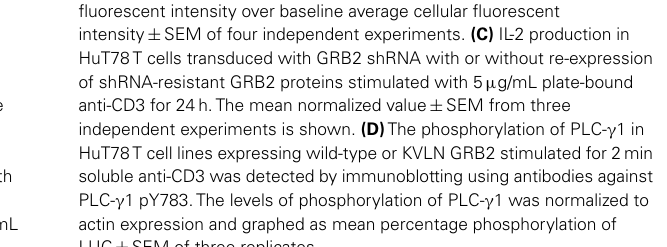
fluorescent intensity over baseline average cellular fluorescent intensity ± SEM of four independent experiments. (C) IL-2 production in HuT78T cells transduced with GRB2 shRNA with or without re-expression of shRNA-resistant GRB2 proteins stimulated with 5 µ g/mL plate-bound anti-CD3 for 24h.The mean normalized value ± SEM from three independent experiments is shown. (D) The phosphorylation of PLC- γ 1 in HuT78T cell lines expressing wild-type or KVLN GRB2 stimulated for 2min soluble anti-CD3 was detected by immunoblotting using antibodies against PLC- γ 1 pY783.The levels of phosphorylation of PLC- γ 1 was normalized to actin expression and graphed as mean percentage phosphorylation of LUC ± SEM of three